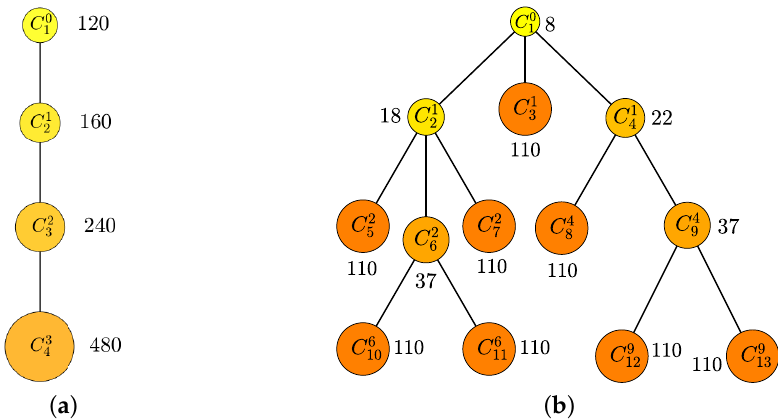
Figure 8. Example of P3: ( a ) the fully ordered set and ( b ) the partially ordered set. The number next to each node is reward R m . As a detailed example of Fig. 5, when U C = 1000 and w = 1, ( a ) is a = 480, and ( b ) is a = 110.